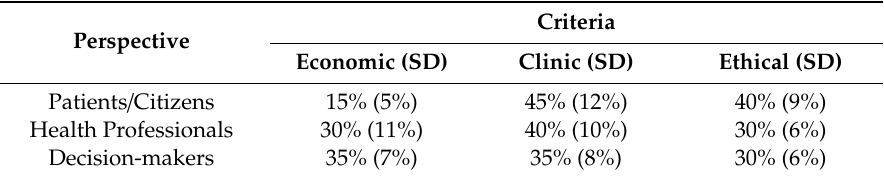
Table 1. Weights assigned to the di ff erent perspectives (Standard